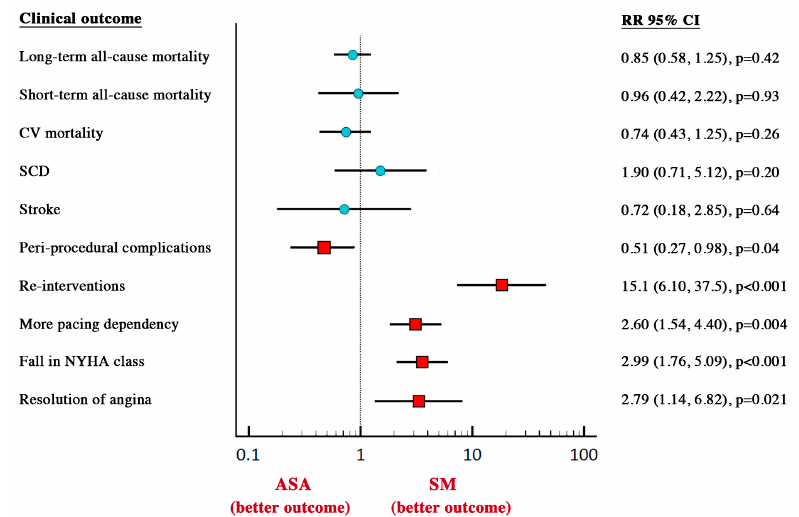
Figure 4. Summary of clinical outcome in two groups of treatment. ASA, alcohol septal ablation; SM, surgical myectomy; CI, confidence interval, CV, cardiovascular, SCD, sudden cardiac death, RR, relative risk, NYHA, New York Heart Association.